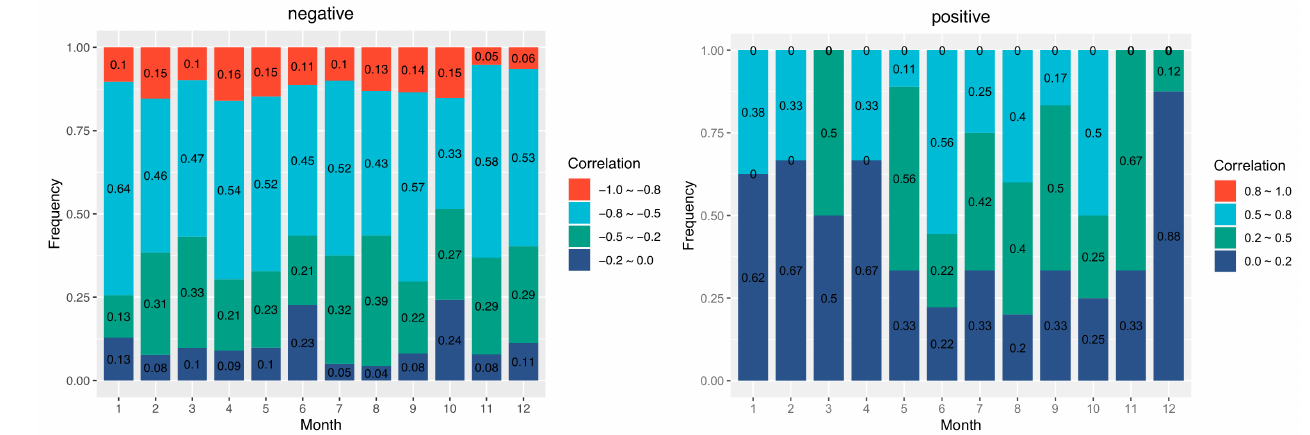
Figure 3. The monthly variations of the frequency of negative CBO and positive CBO.